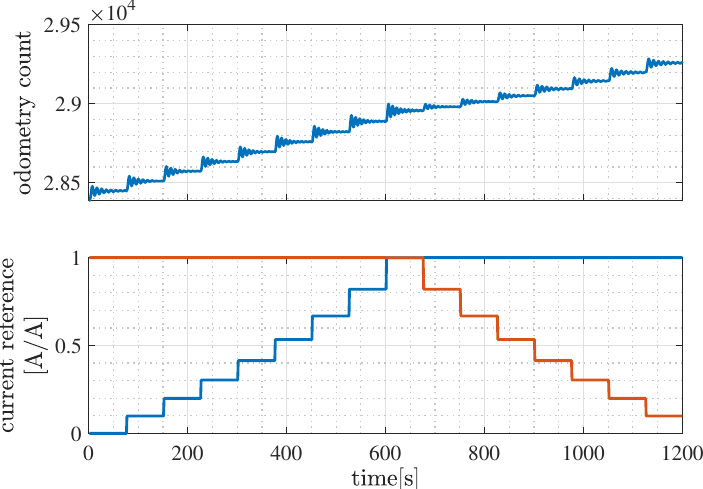
Figure 18. Zoom on the region of rapid change in amplitude of shaft oscillation with related A (red) B (blue) coil currents reference